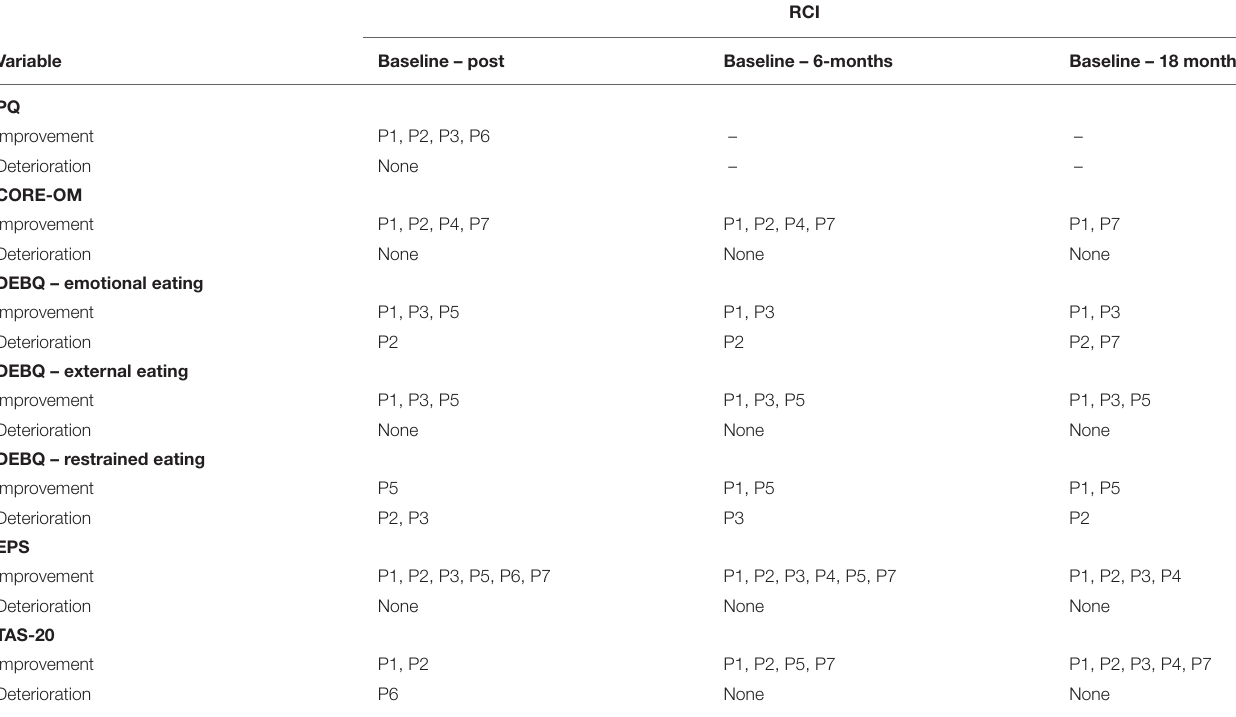
TABLE 2 | Rates of reliable change in outcome measures at post-intervention, 6-month and 18-month follow-ups.